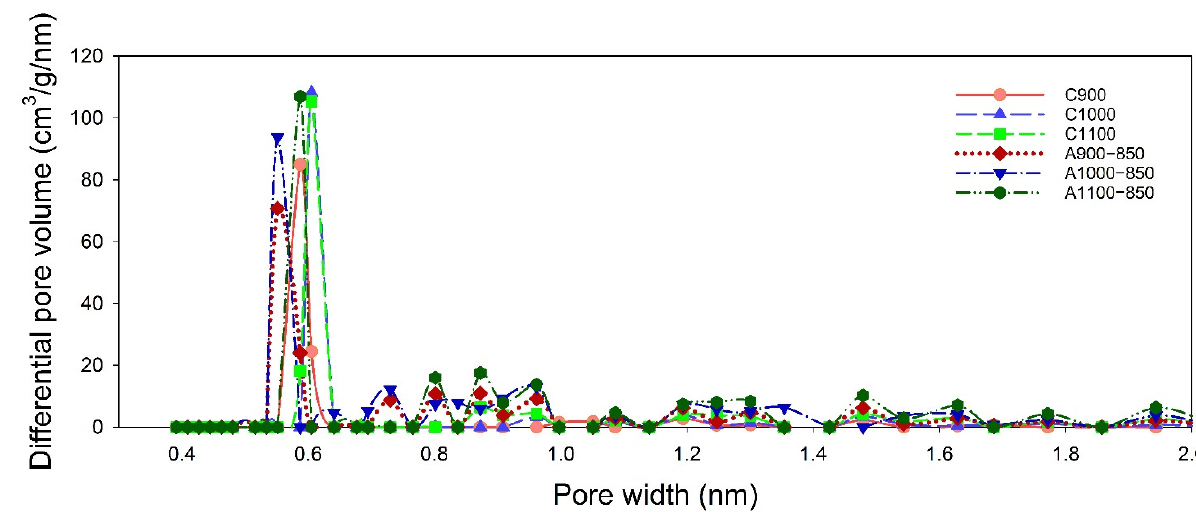
Figure 7. Pore size distributions of the samples, derived from the N 2 adsorption isotherms at − 196 °C by the NLDFT model.